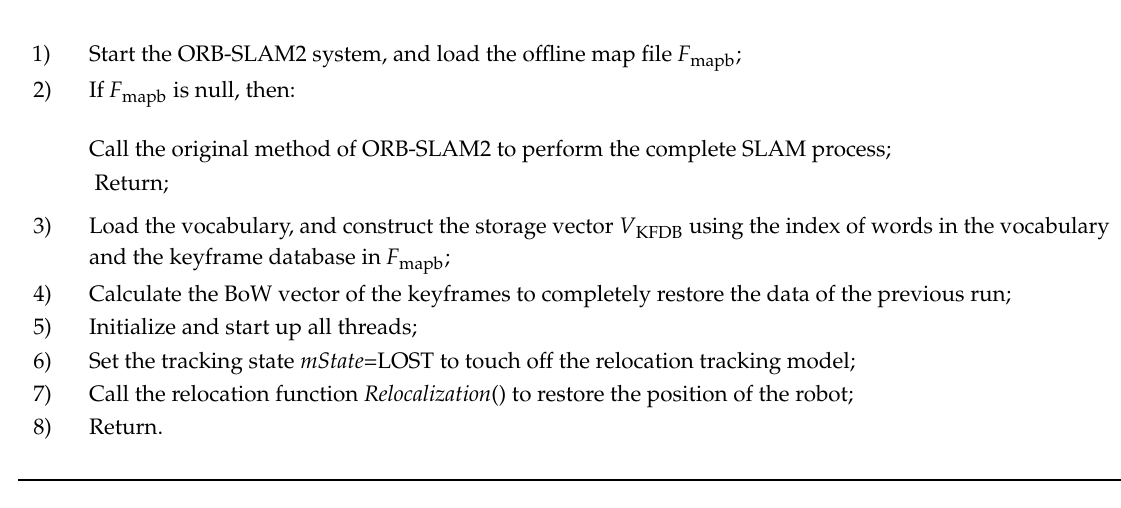
Algorithm 4: Fast Relocation Method Based on Offline